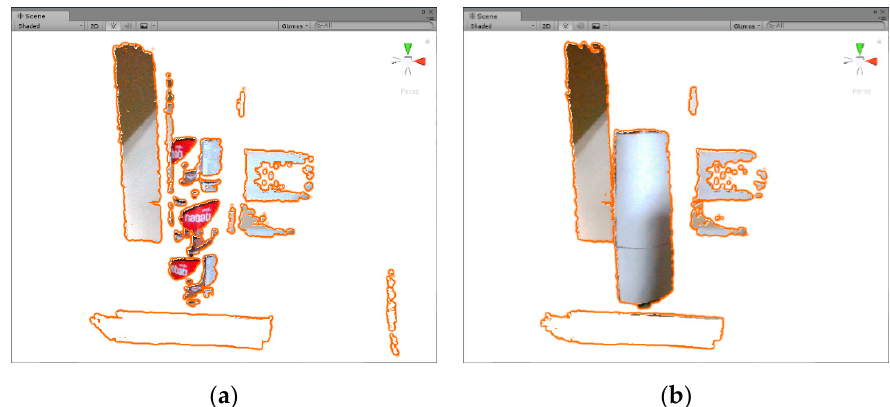
Figure 19. Characteristics of the SR300 sensor: ( a ) A diffuse reflection due to the characteristics of the can material; ( b ) surface treatment to reduce diffuse reflections.